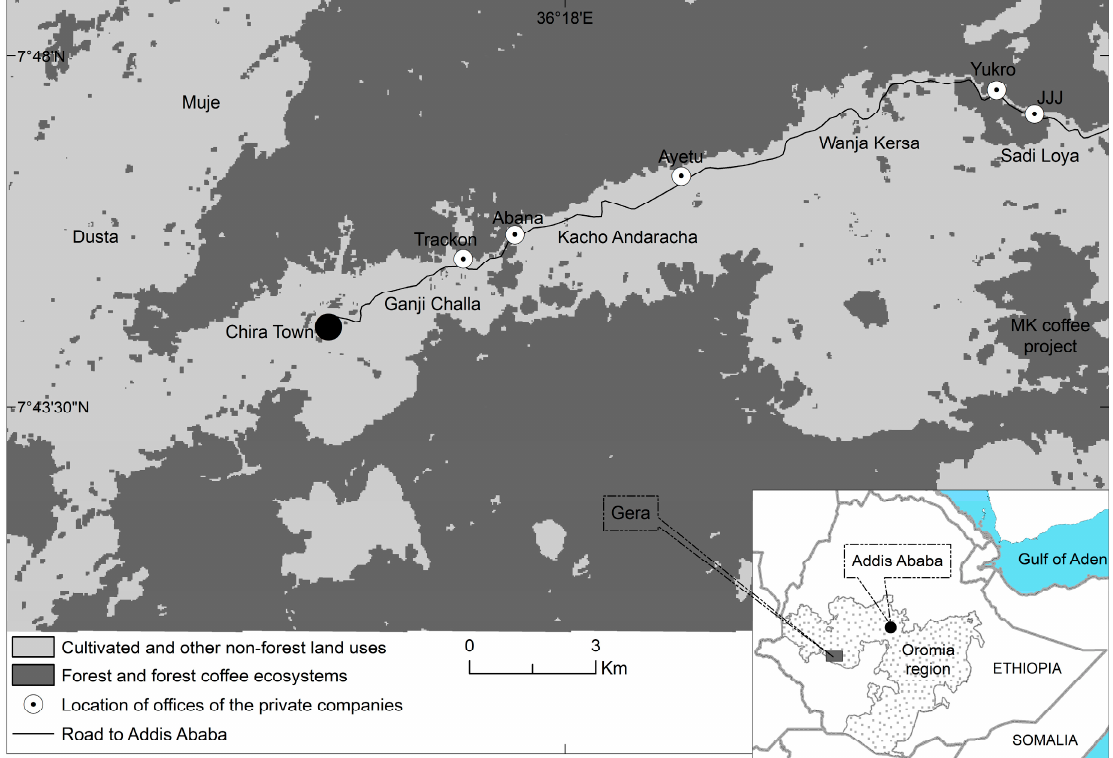
Figure 1. Location of the study area and the private companies engaged in coffee production. The land transferred to the companies is located adjacent to their respective offices indicated on the map. The background land-cover map was produced from a free Landsat image from 5 November 2010 (http://glovis.usgs.gov).